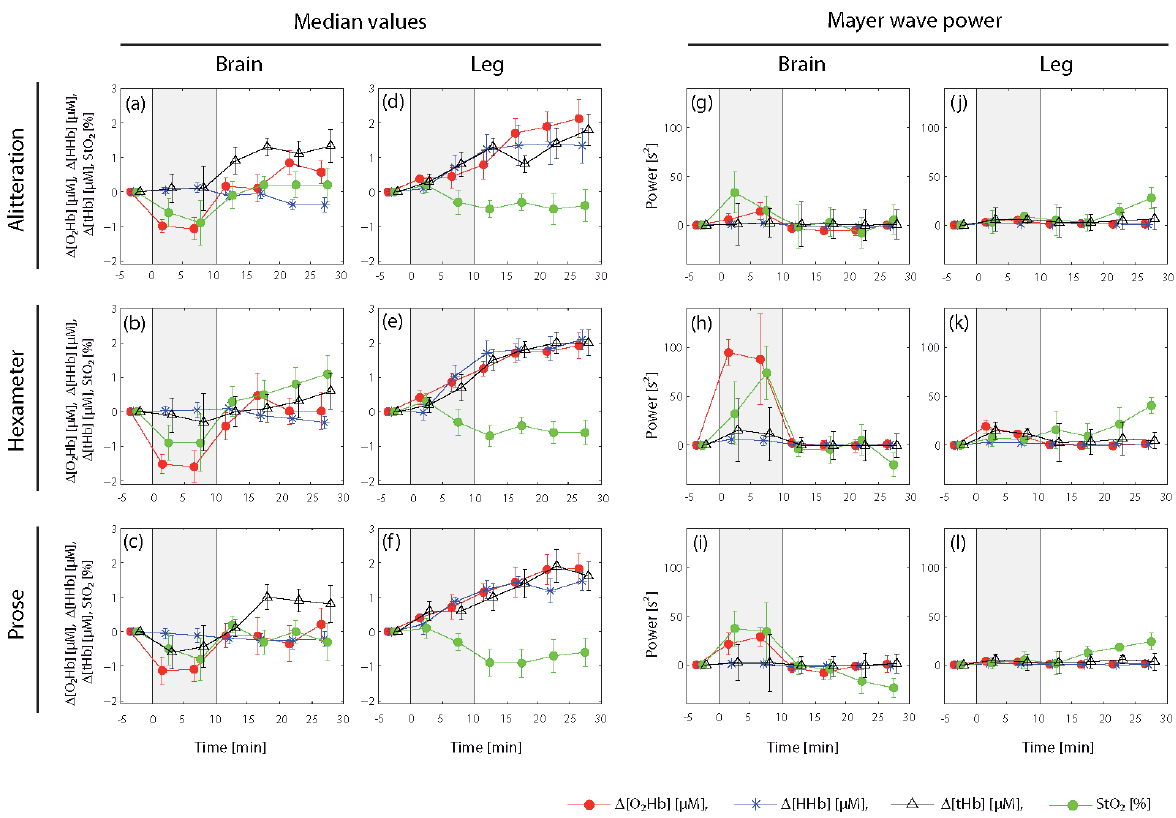
FIGURE 1. Results of the data analysis in the time and frequency domain. Subfigures a–f show the changes in the hemodynamic and oxygenation signals during the three different speech tasks measured in the brain (a–c) and the leg (d–f). For the brain, clear changes are visible during recitation, mostly a reduction in Δ[O is probably due to a CO reaction and an increase in oxygen consumption. In the leg, Δ[O 2 increase continuously, probably due to venous pooling. The corresponding changes in the MWP are shown in the subfigures g–i and j–l, respectively. In the brain, MWP is elevated for Δ[O significantly higher increase during hexameter recitation. This probably indicates an activation of the sympathetic nervous system. The data were set to zero during the baseline period before recitation to enhance visibility of the changes. The error bars represent the bootstrap estimate of the standard error of the median, calculated according the approach presented in Martinez and